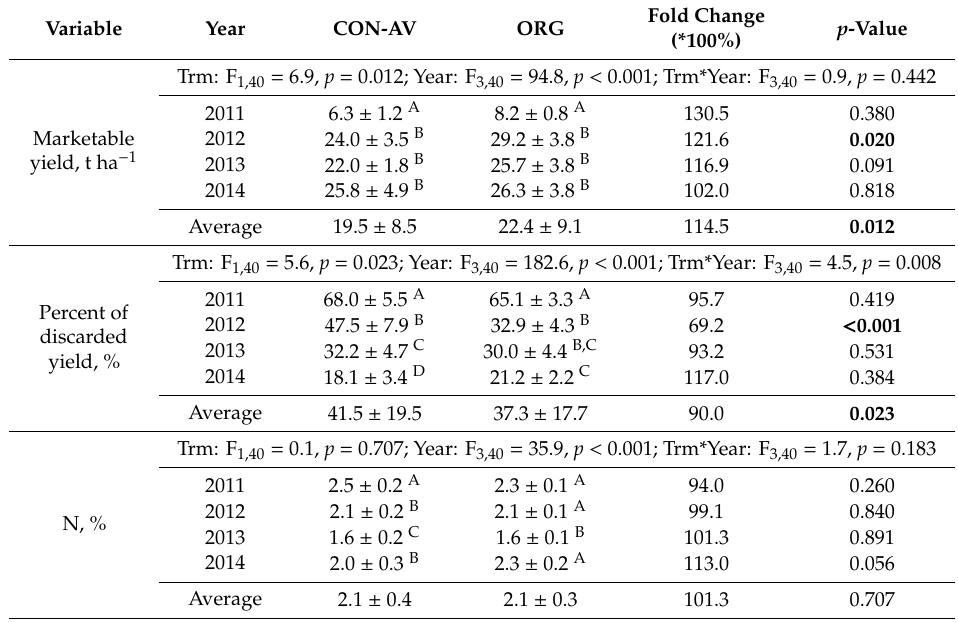
Table 3. Marketable and discarded yield and content of nitrogen, nitrates, vitamin C, sugars, and dry matter (DM) in conventional (average of three conventional treatments, CON-AV) and organic (ORG) treatments (mean ± standard error); fold change indicates the change of ORG with respect to CON-AV (ORG / CON-AV) and p-value shows the statistical significance of the di ff erence between CON-AV and ORG (significant p -values < 0.05 are presented in bold). For each variable results of two way analysis of variance (F-statistics and p -values) of the factors treatment (Trm), year, and treatment by year interaction (Trm*Year) are also